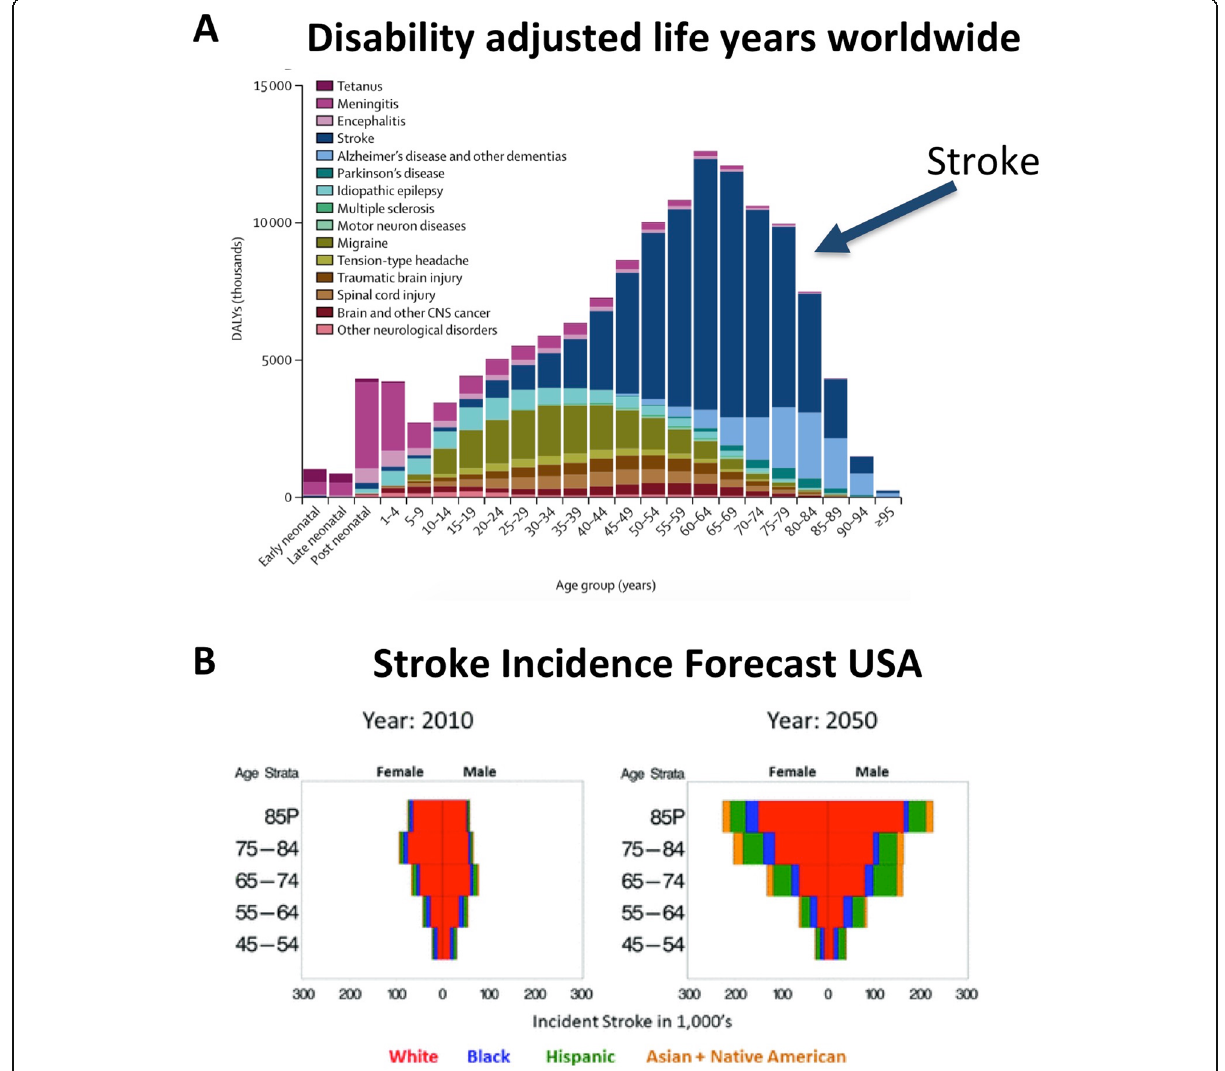
Fig. 1 Stroke impact on society. a Disability-adjusted life years for 15 neurological disorder categories worldwide. With increasing age, stroke contributes the most to life years lost by death or disability. Shown are estimates for male persons; the graphs for females show similar percentages. Modified from the Global Burden of Disease Study group (2019, [20]). b Projection of the distribution of incident stroke events in the US for the years 2010 and 2050, separated by ethnicity and age. Especially the proportion of very old patients (> 85 years) is expected to strongly increase over the next three decades. From [35] (with